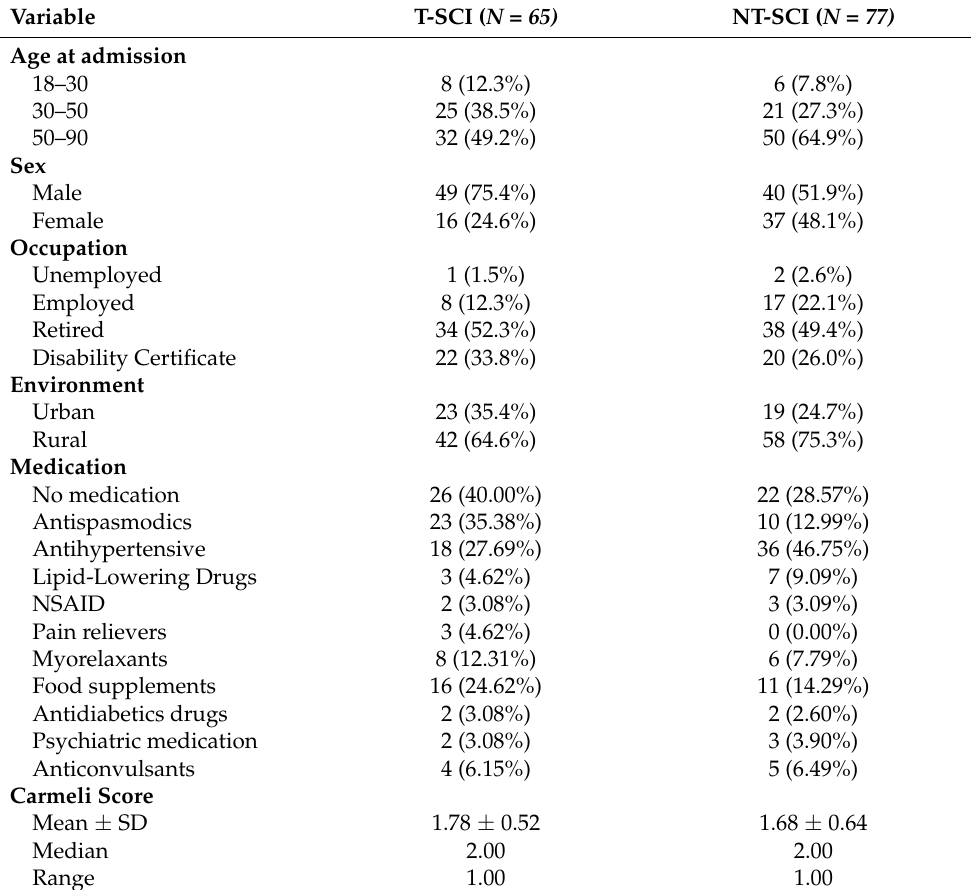
Table 1. Patients